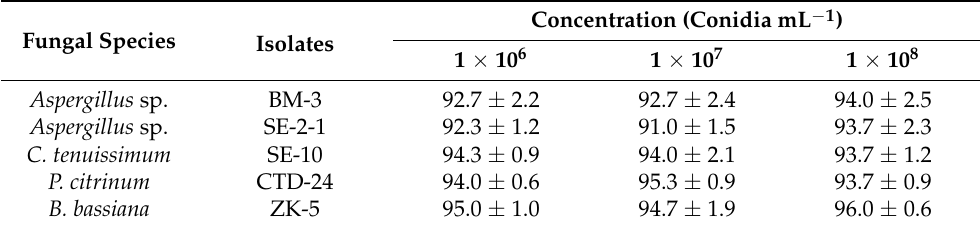
Table 2. Germination rates of the entomopathogenic fungal isolates used in the study. Fungal Species